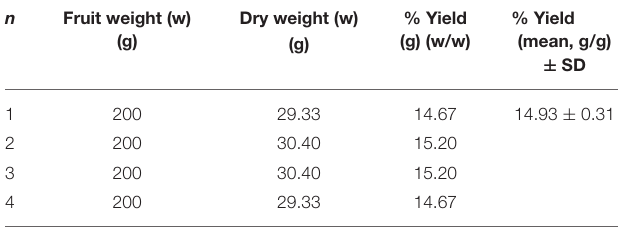
TABLE 1 | Percentage yield of Caesalpinia spinosa aqueous extract of dried fruits. n Fruit weight (w)